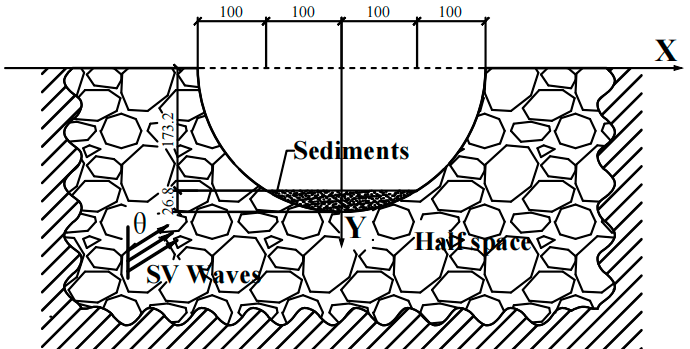
Figure 2. Sedimentary valley model